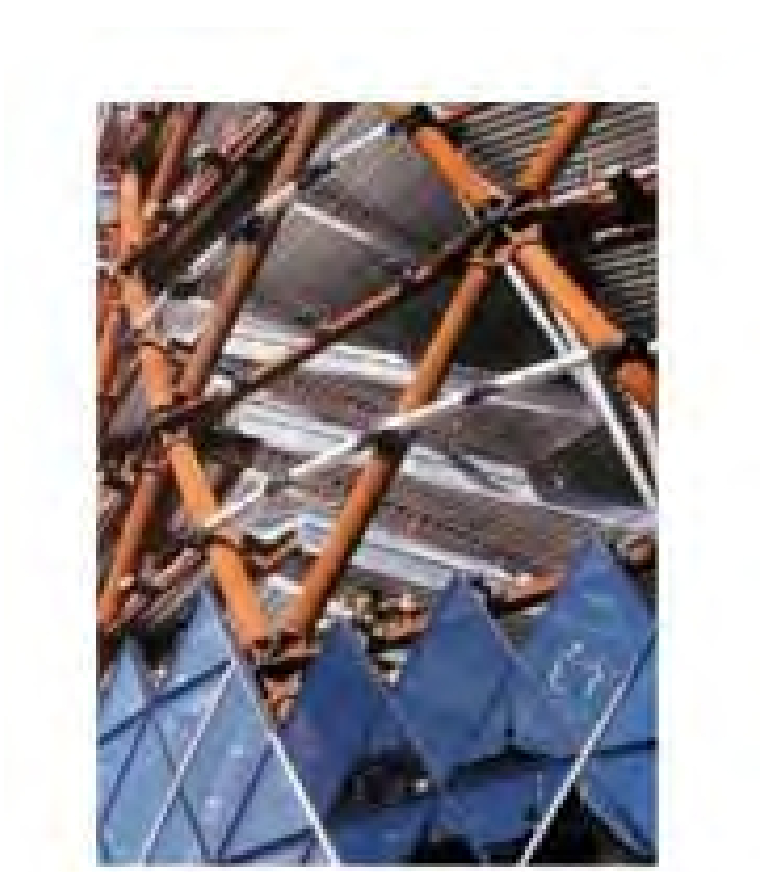
Figure 13. (Swiss Re Headquarters) under construction